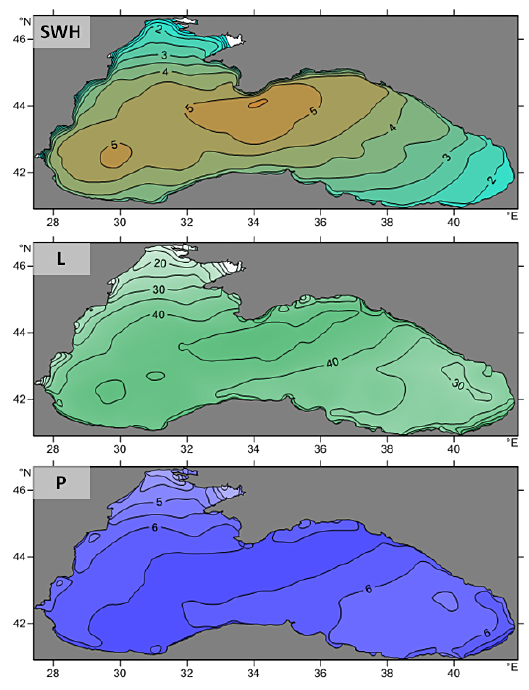
Figure 11. Maps of calculated significant wave height [m], wave length [m] and period [s] maxima in